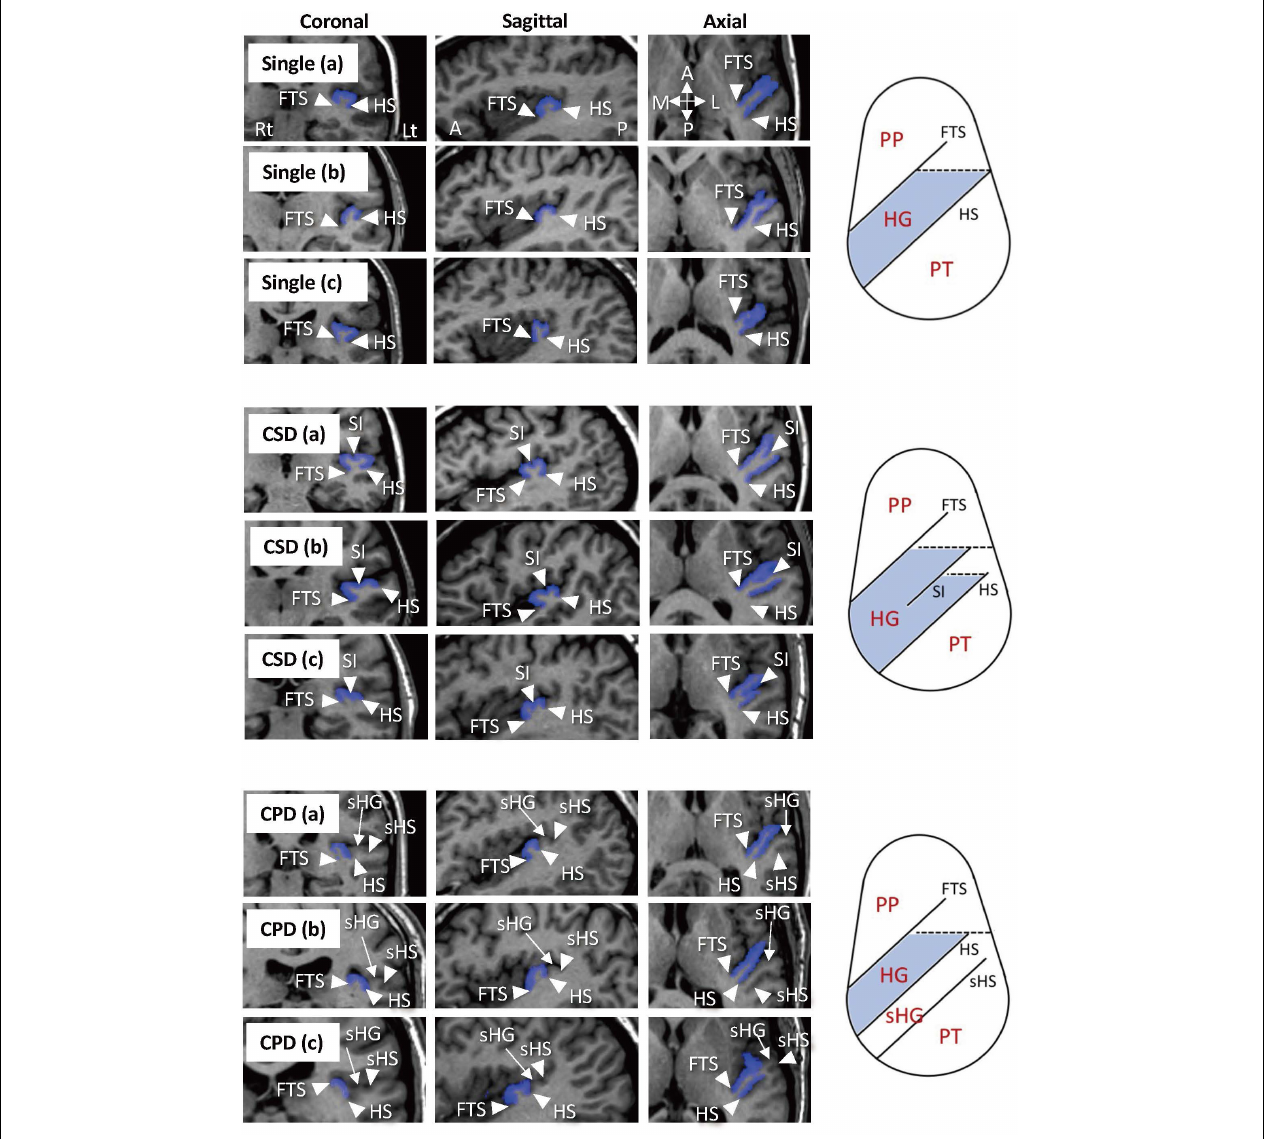
FIGURE 1 | Sample images of various Heschl’s gyrus (HG) patterns and anatomical landmarks on MR images and on pattern diagrams in axial direction. The HGs on the left hemisphere are colored in blue. Subjects with a single HG pattern sometimes had a small branching at the front tip [Single (b)] (Marie et al., 2015) or a shallow cortical dimple at the crown of the HG [Single (c)]. Two hemispheres in the present study that had a separate HG posterior to the HG with partial duplication were considered to have the CSD pattern [CSD (c)]. One subject had a pattern of three separate HGs in the left hemisphere, which was classified as a variation of CPD [CPD (c)]. A, anterior; CPD, complete posterior duplication; CSD, common stem duplication; FTS, first transverse sulcus; HS, Heschl’s sulcus; L, lateral; P, posterior; M, medial; PP, planum polare; PT, planum temporale; sHG, second Heschl’s gyrus; sHS, second Heschl’s sulcus; SI, sulcus